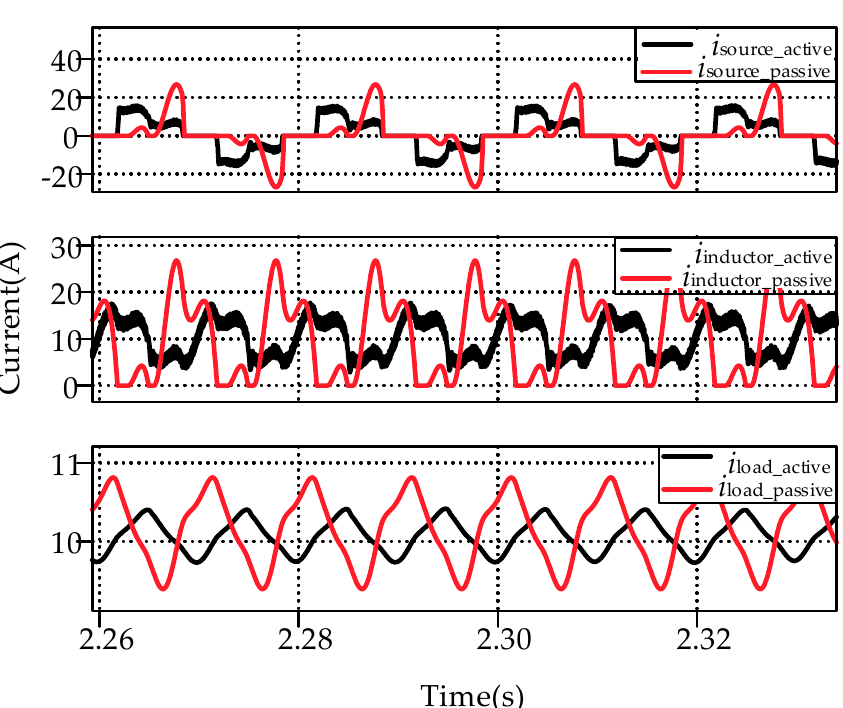
Figure 6. Simulation results comparison between passive magnetic inductor and active variable inductor under unbalanced grid voltage condition. Top: grid-side current; Middle: DC-link current; Bottom: load current. Red: passive magnetic inductor; Black: variable active inductor.